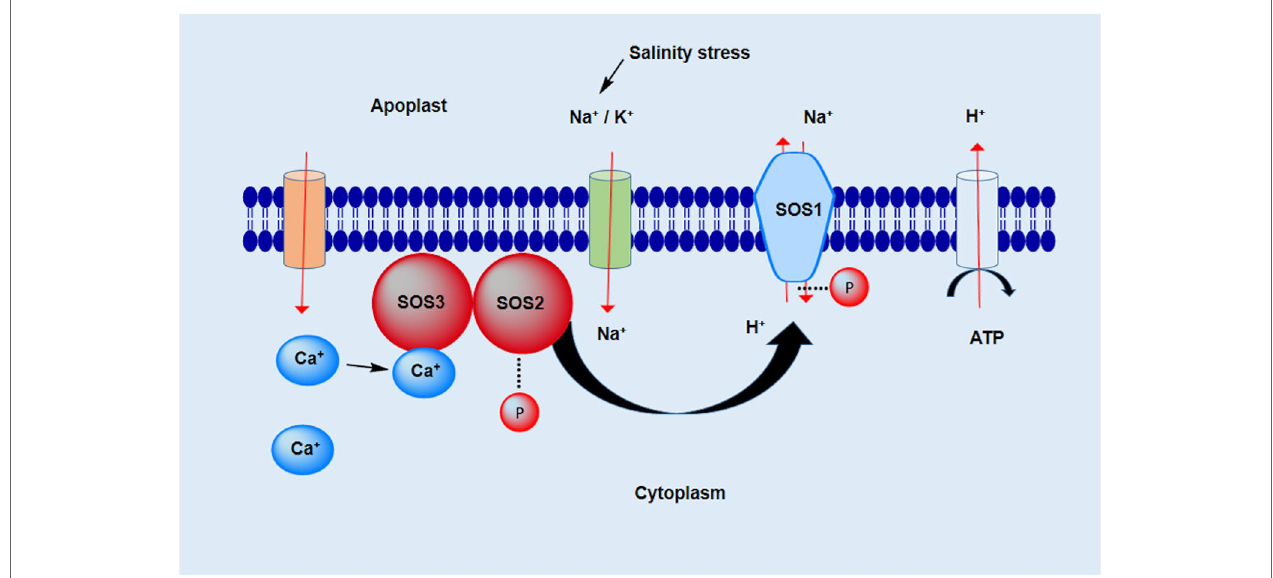
FIGURe 2 | SOS pathway under salinity stress. The transport of ions across the membrane is conducted by various carrier proteins, e.g. channel proteins, antiporters, and symporters. The ion hemostasis (Na + , K + , and Ca 2+ ) in the cell is crucial for its survival under salt-stress conditions.